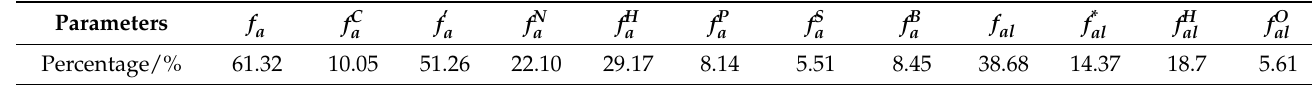
Table 3. Carbon structural parameters of Kerjian coal.